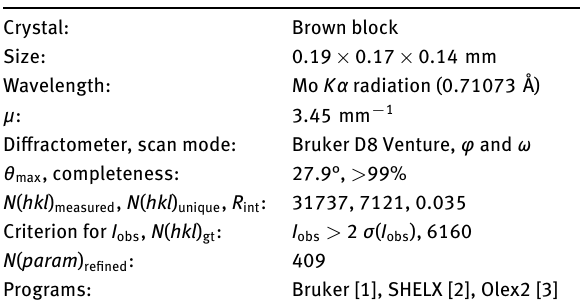
Table 1: Data collection and handling.